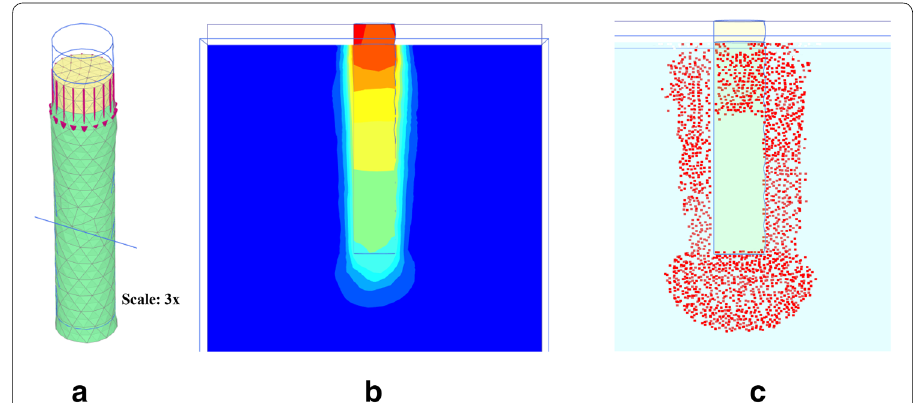
Fig. 3 Column with C u column; c plastic points